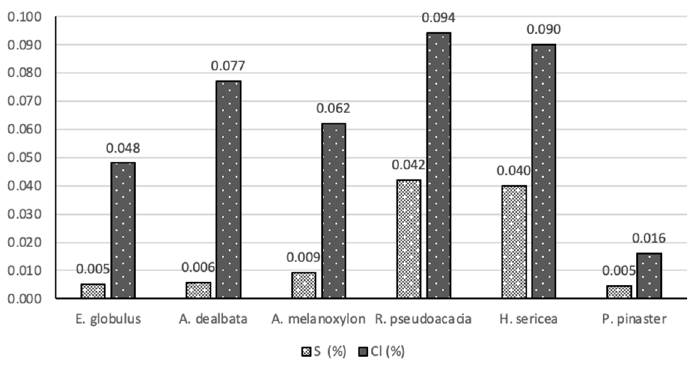
Figure 4. Sulphur and chlorine